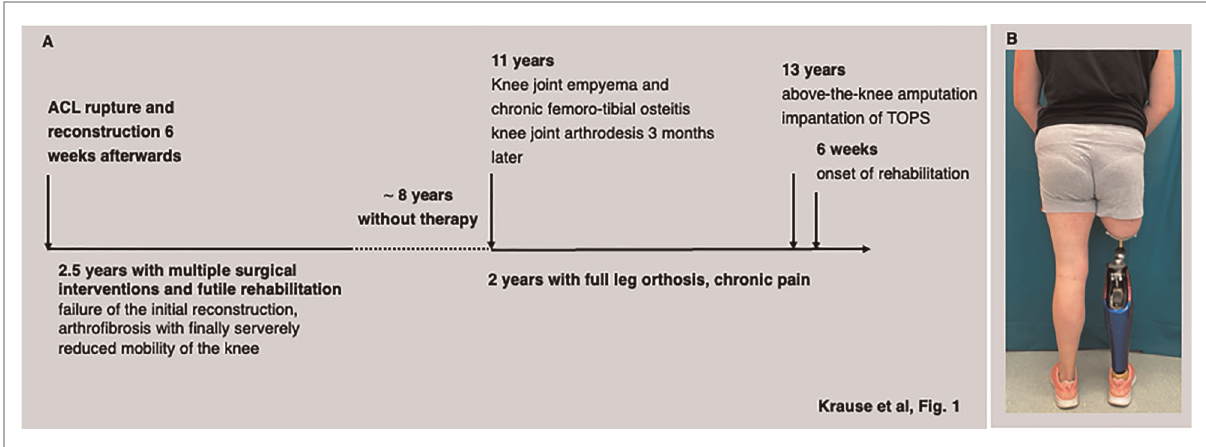
FIGURE 1 History of disease ( A ) and a photograph of the patient 18 months after switching to transcutaneous osseointegrated prosthesis system (TOPS) ( B ).